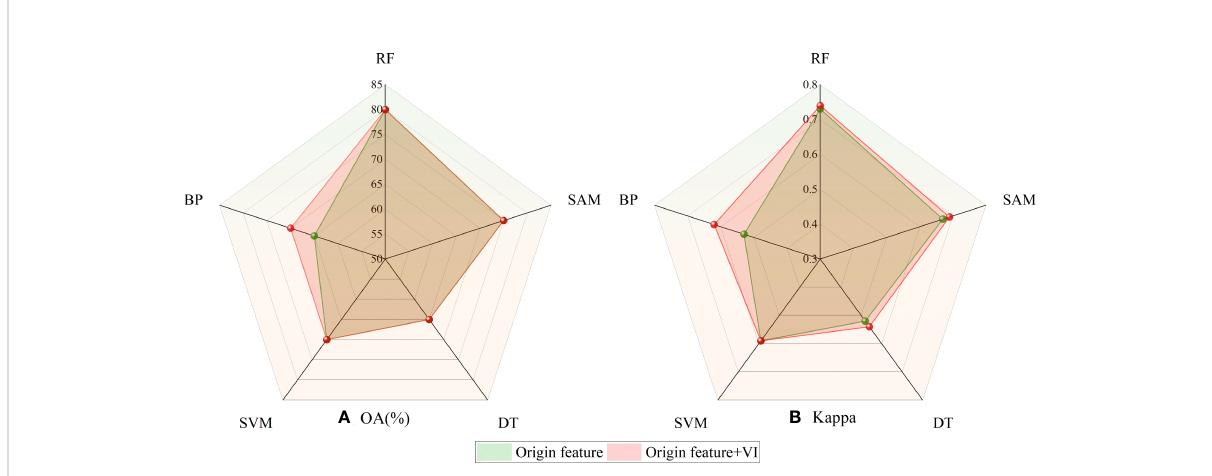
algorithm and the RF algorithm, using Sentinel-2